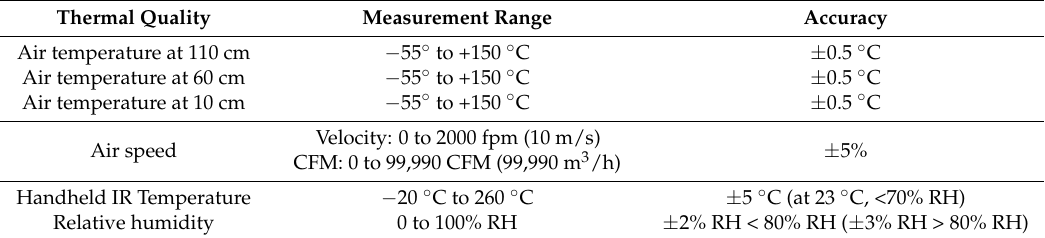
Figure 2. Image of five generations of the Enviro cart, Measure IEQ, with CMU’s National Environmental Assessment Toolkit™. Table 3. Specifications of the thermal quality measurement instrumentation used in this study.